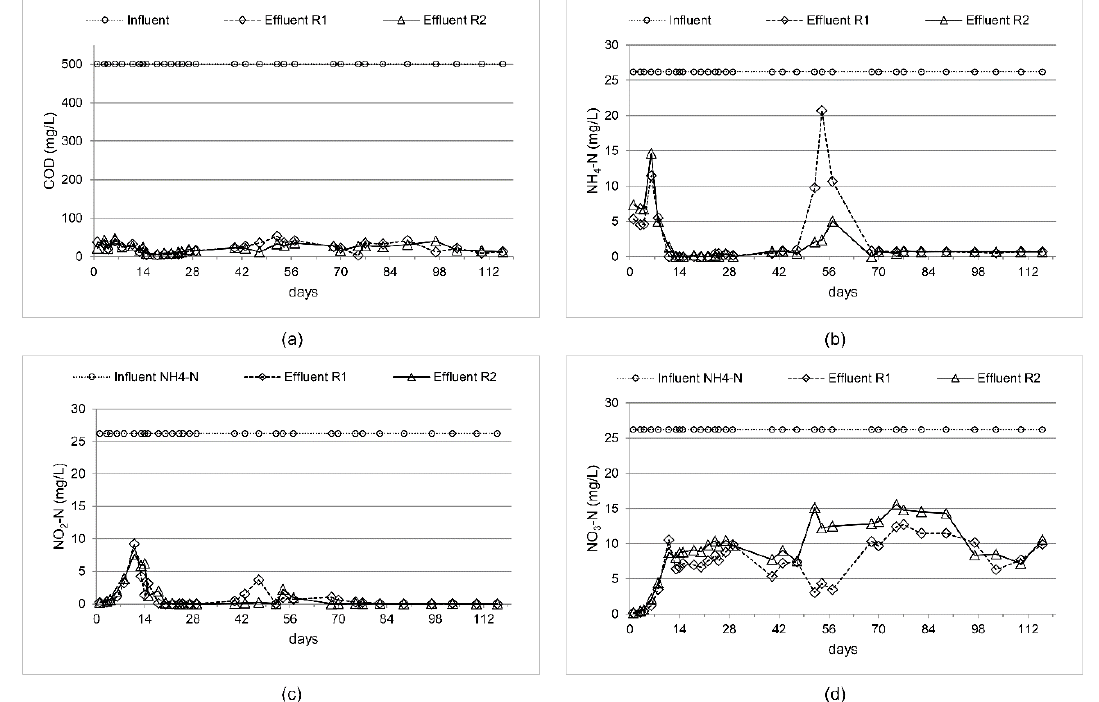
Figure 3. Influent and effluent concentrations of ( a ) COD; ( b ) ammonium; ( c ) nitrite; and ( d ) nitrate in the reactors.